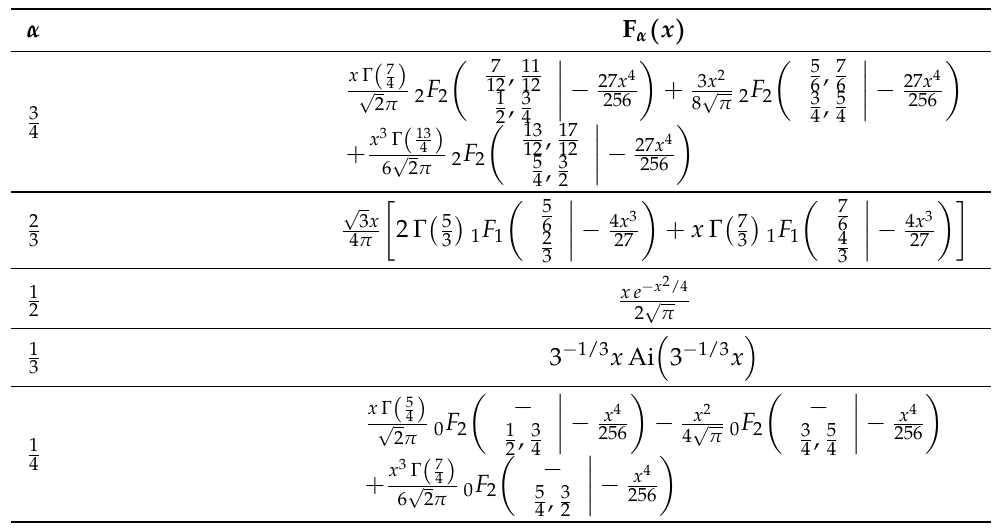
Table A15. The Mainardi function F α derived for some values of parameter α by using (A7).